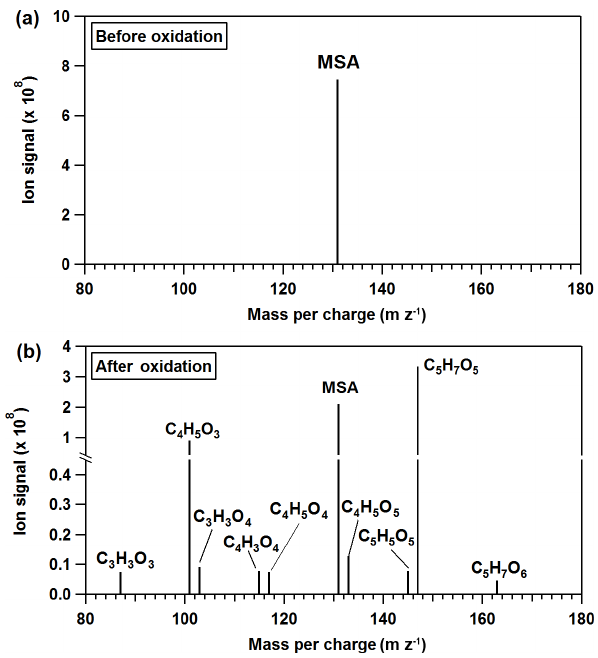
Figure 2. Aerosol mass spectra (a) before and (b) after heteroge- neous OH oxidation of the aqueous methylsuccinic acid droplet. The minor products after oxidation contribute less than 10% of the total ion